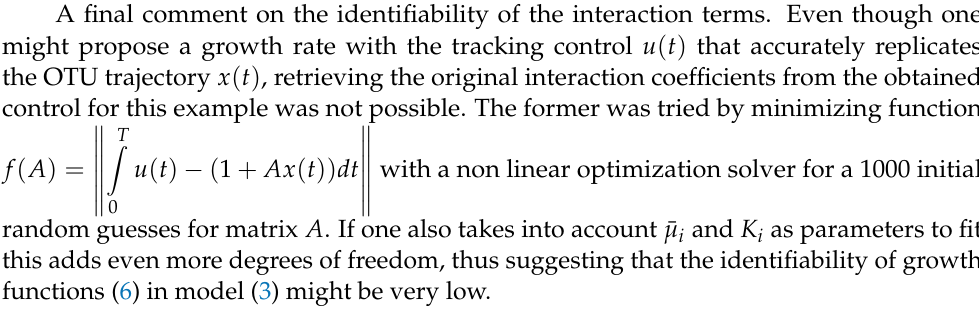
Figure 9. Control and reconstructed growth rate for OTU 2